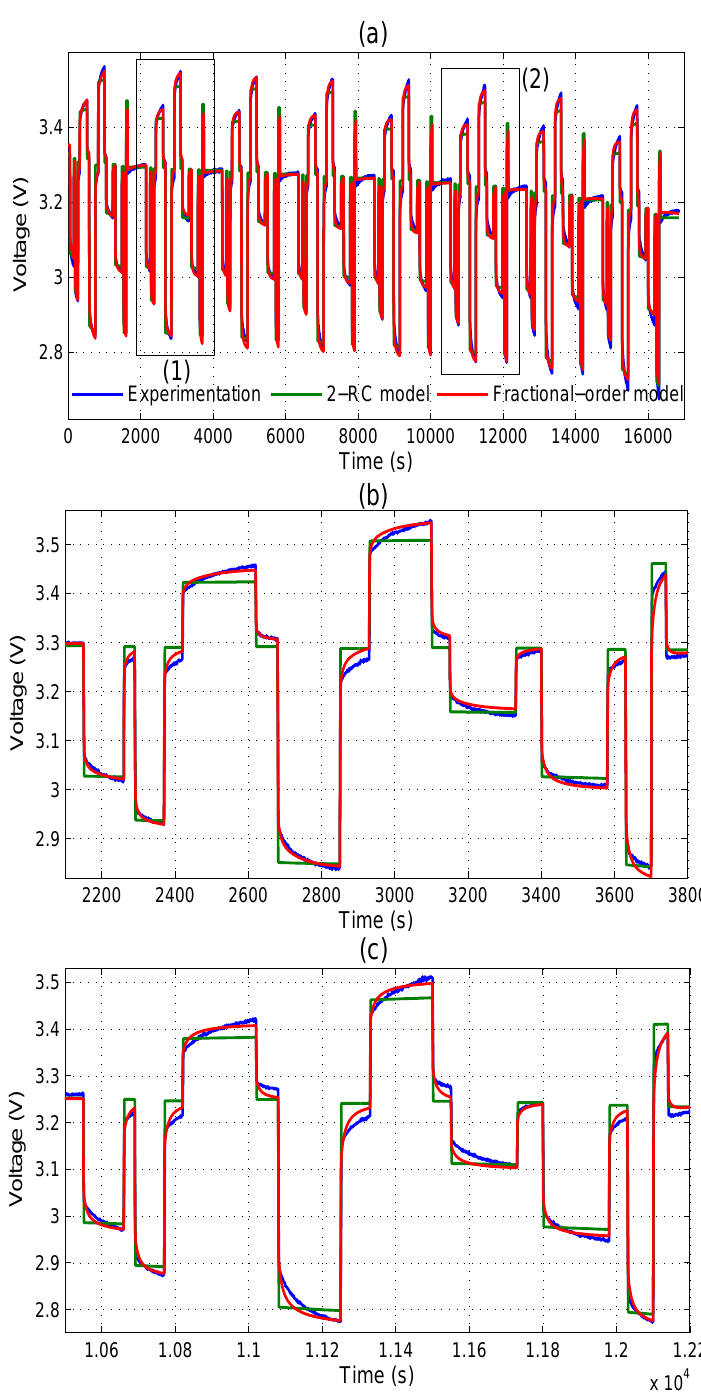
Figure 8. ( a ) Comparison of actual voltages of hybrid pulse test, 2 ‐ RC model output voltages and fractional ‐ order model output voltages for WB ‐ LYP40AHA: all SOC range; ( b ) zoom ‐ in at Section 1; ( c ) zoom ‐ in at Section 2.